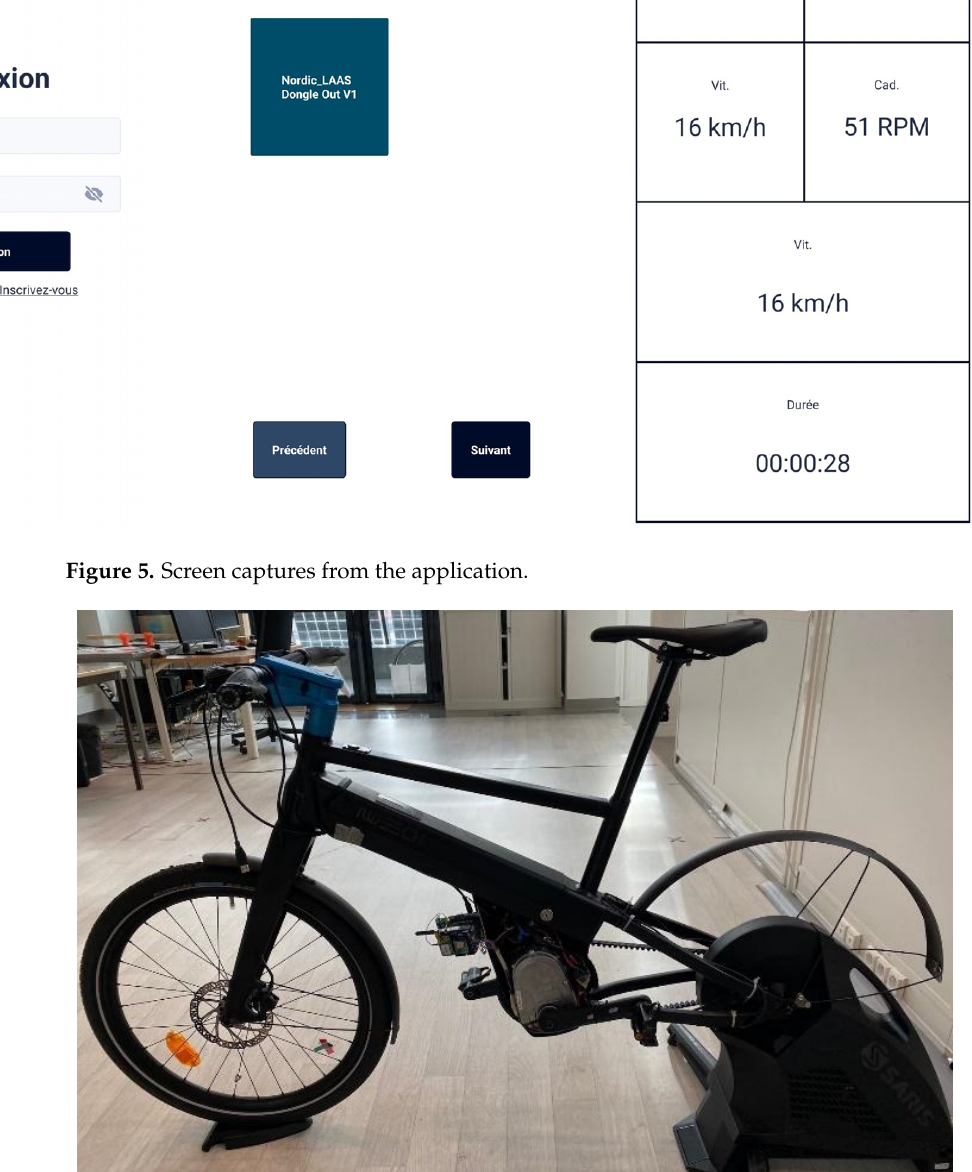
Figure 6. Experimental prototype e-bike mounted on the home trainer Saris.